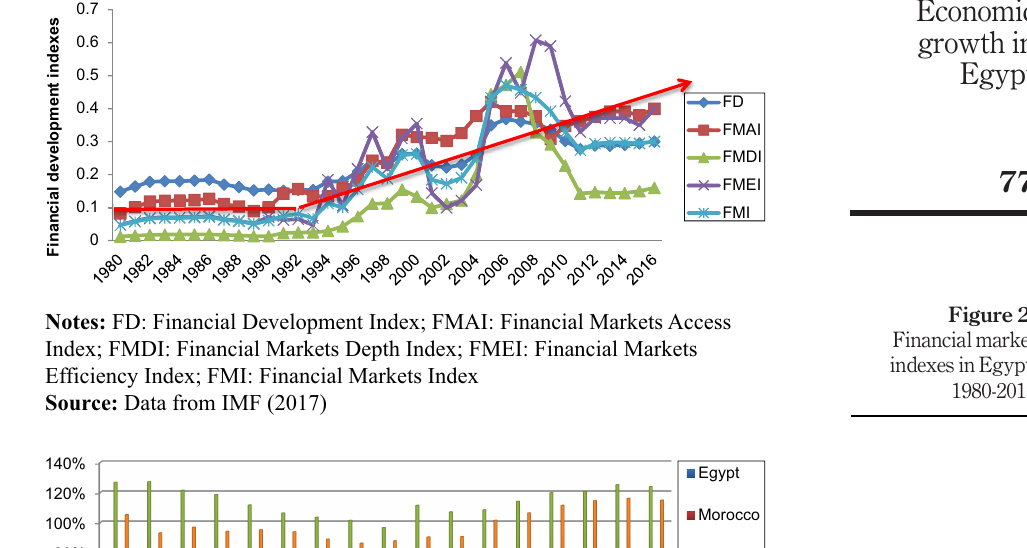
Figure 3. Ratio of private bank credit to GDP in six middle-income